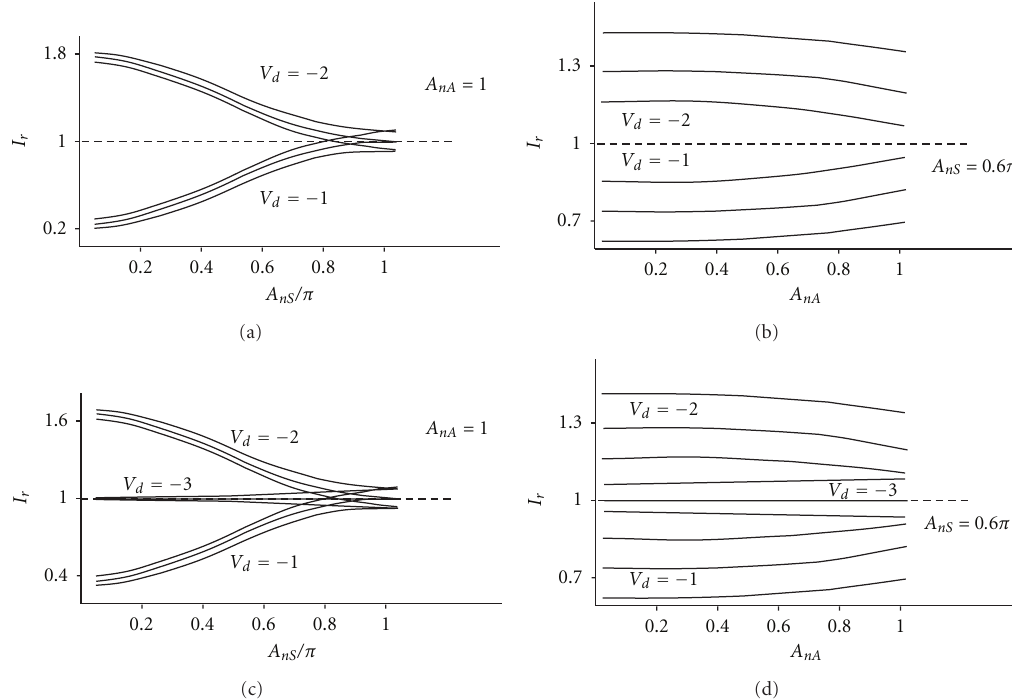
Figure 4: Influence of phase and amplitude noise with amplitudes A nS and A nA on maximum and mean values of intensity (cid:5) I r (cid:6) calculated over 150 realizations. Results were obtained with Δ = 180 ◦ and ϕ = 0 (a, b) and with Δ = 180 ◦ and ϕ = 0 (c, d). Amplitudes of noise were taken as A nA = 0 . 5 (a, c) and A nS = 0 . 6 π (b, d). The mean values of intensity calculated according to (21) coincide with curves in figures.